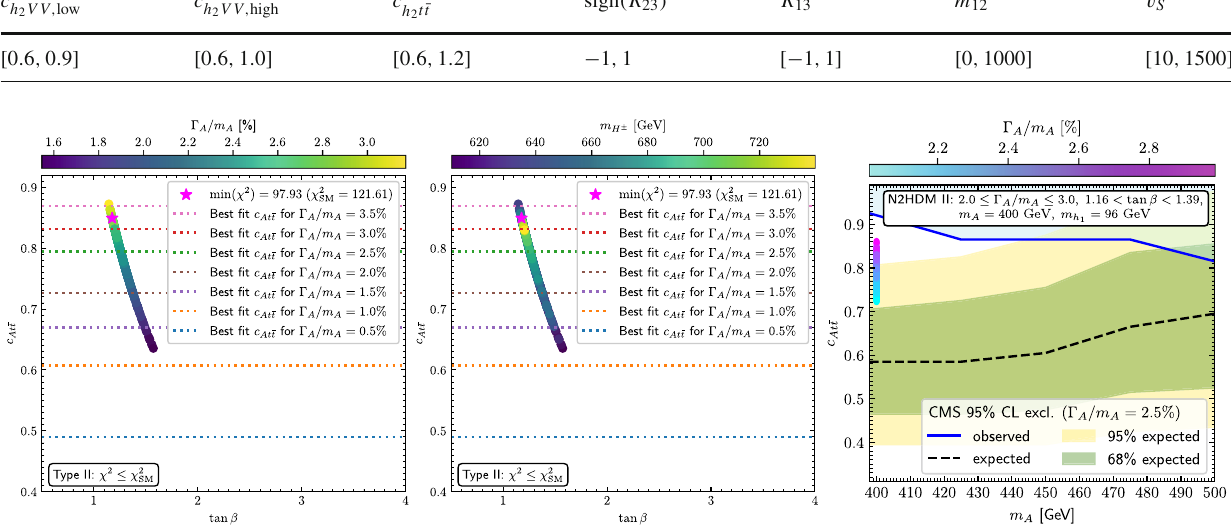
Fig. 6 Left and center: c At ¯ t in dependence of tan β . The colors of the points indicate the values of (cid:8) A / m A in % (left) and the values of m H ± (center). The dashed horizontal lines indicate the best-fit values of c At ¯ t for different width hypotheses in the experimental analysis [6]. Right: Values of c At ¯ t for the parameter points with 2 . 0% ≤ (cid:8) A / m A ≤ 3 . 0%